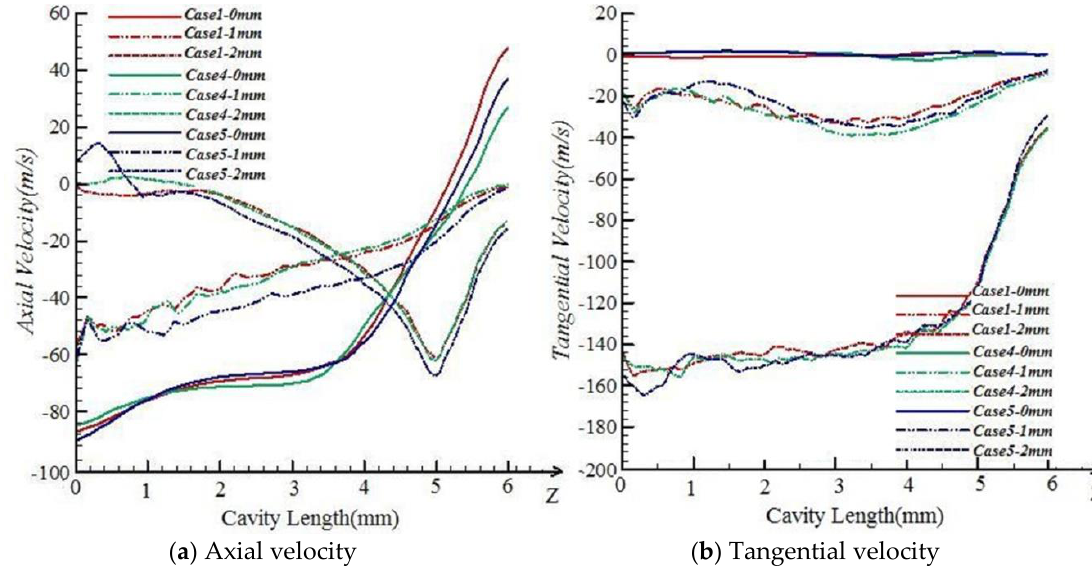
Figure 8. Velocity comparisons among Case1, Case4, and Case5.